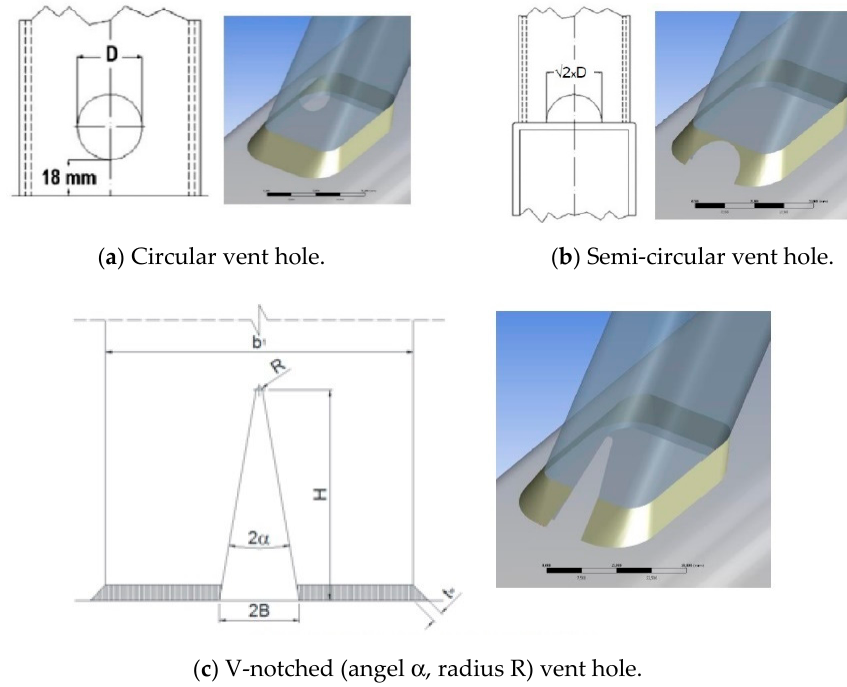
Figure 2. Configuration of different vent holes.